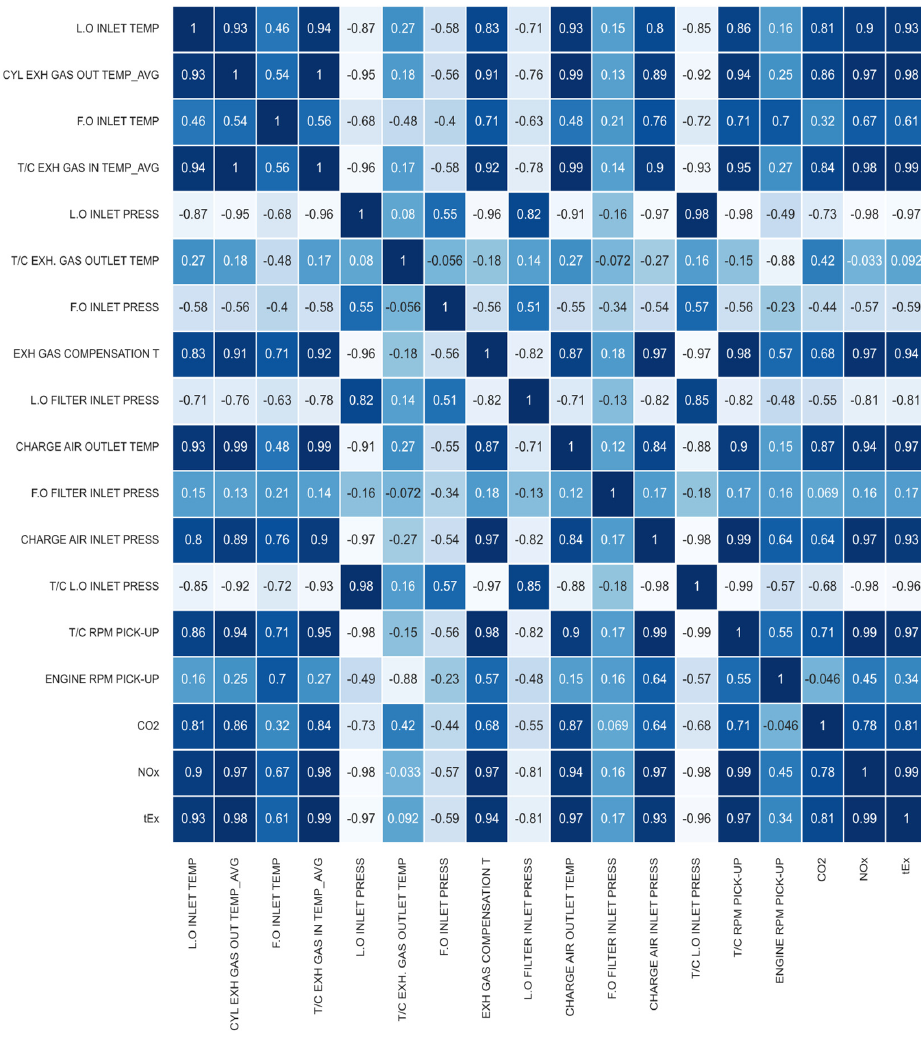
Figure 4. Correlation heatmap of Da ‐ sx.